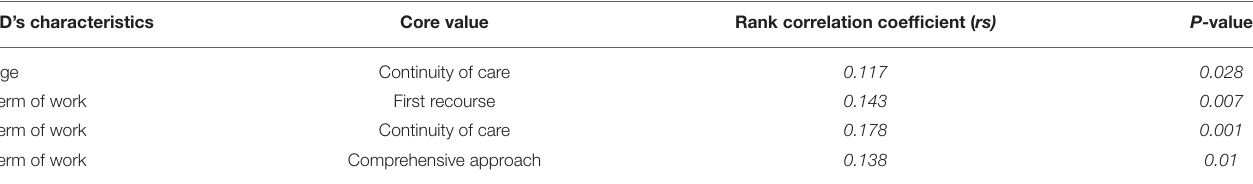
TABLE 4 | Spearman’s rank correlations between the FD characteristics and their ranking of